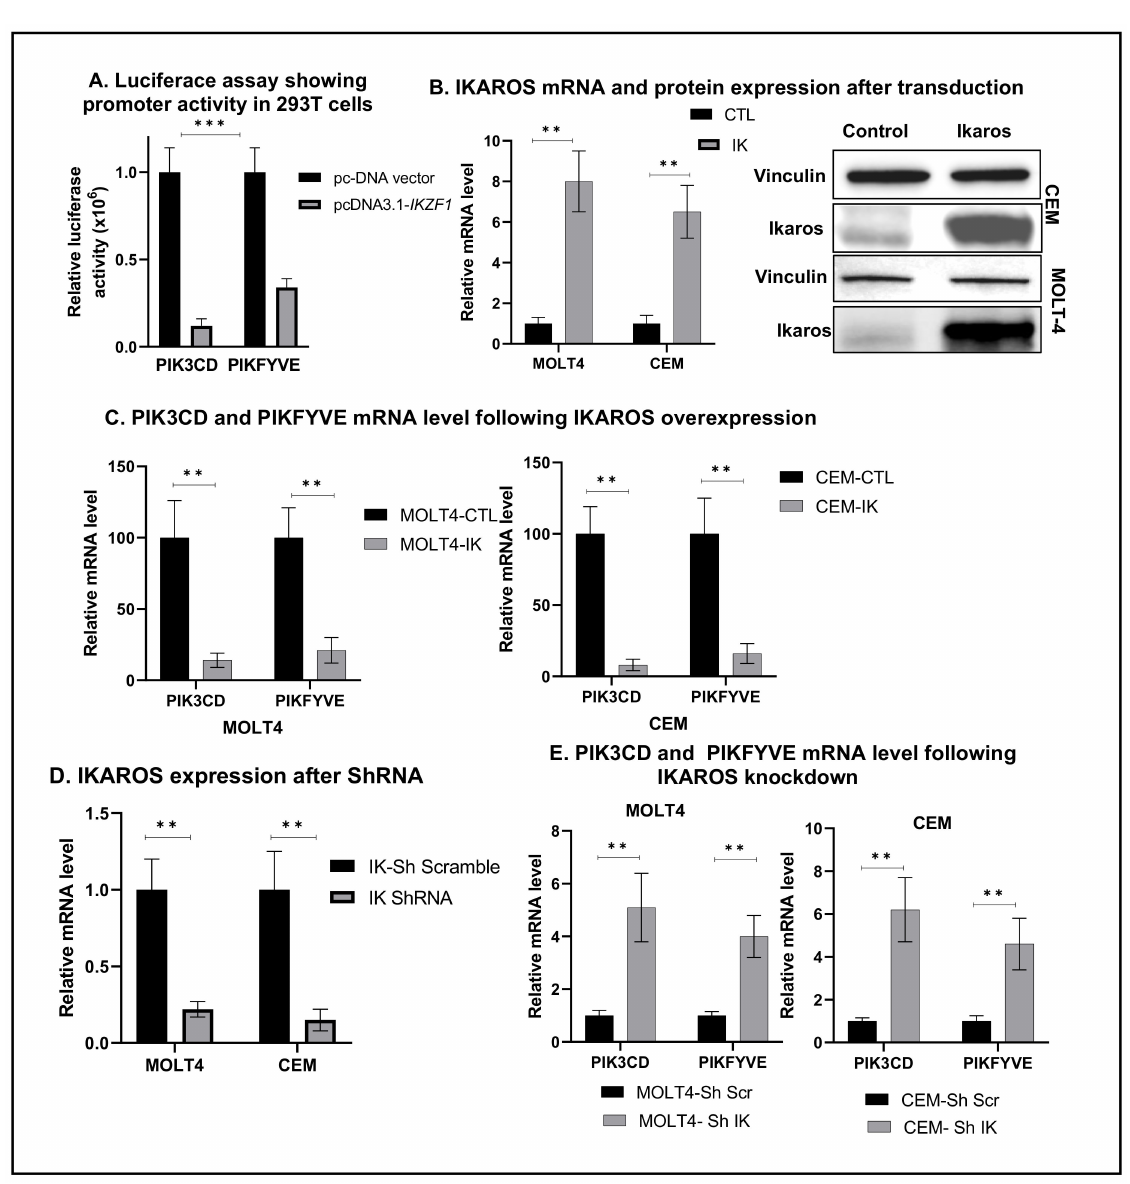
Figure 3. IKAROS represses PIK3CD and PIKFYVE gene transcription in T-ALL . Luciferase reporter assay was per- formed on HEK 293T cells transfected with the IKZF1 plasmid (pcDNA 3.1-IK) or a control vector (pcDNA3.1). The result in ( A ) shows repression of the PIK3CD and PIKFYVE luciferase promoter construct by the IKAROS-expressing vector pcDNA3.1-IK in comparison to the pcDNA3.1 empty vector control in HEK 293T cells. ( B ) CEM and MOLT4 cells were transduced to express IKZF1 (MIG-IK) or with an empty vector (MIG-CTL). Relative mRNA expression of IKAROS following transduction. ( C ) mRNA level of PIK3CD and PIKFYVE in IKAROS-overexpressed (left panel) MOLT4 and (right panel) CEM cells assessed using qRT-PCR. ( D ) MOLT4 and CEM cells were treated with IKZF1 shRNA (shIK) or scrambled shRNA control (shCTL). The relative expression of IKZF1 (left panel) assessed by qRT-PCR. ( E ) mRNA level of PIK3CD and PIKFYVE in MOLT4 (left panel) and CEM (right panel) cells. Results are mean ± SD of triplicates representative of one of three independent experiments. The p -value summaries are as follows: p < 0.01 (**); p < 0.001